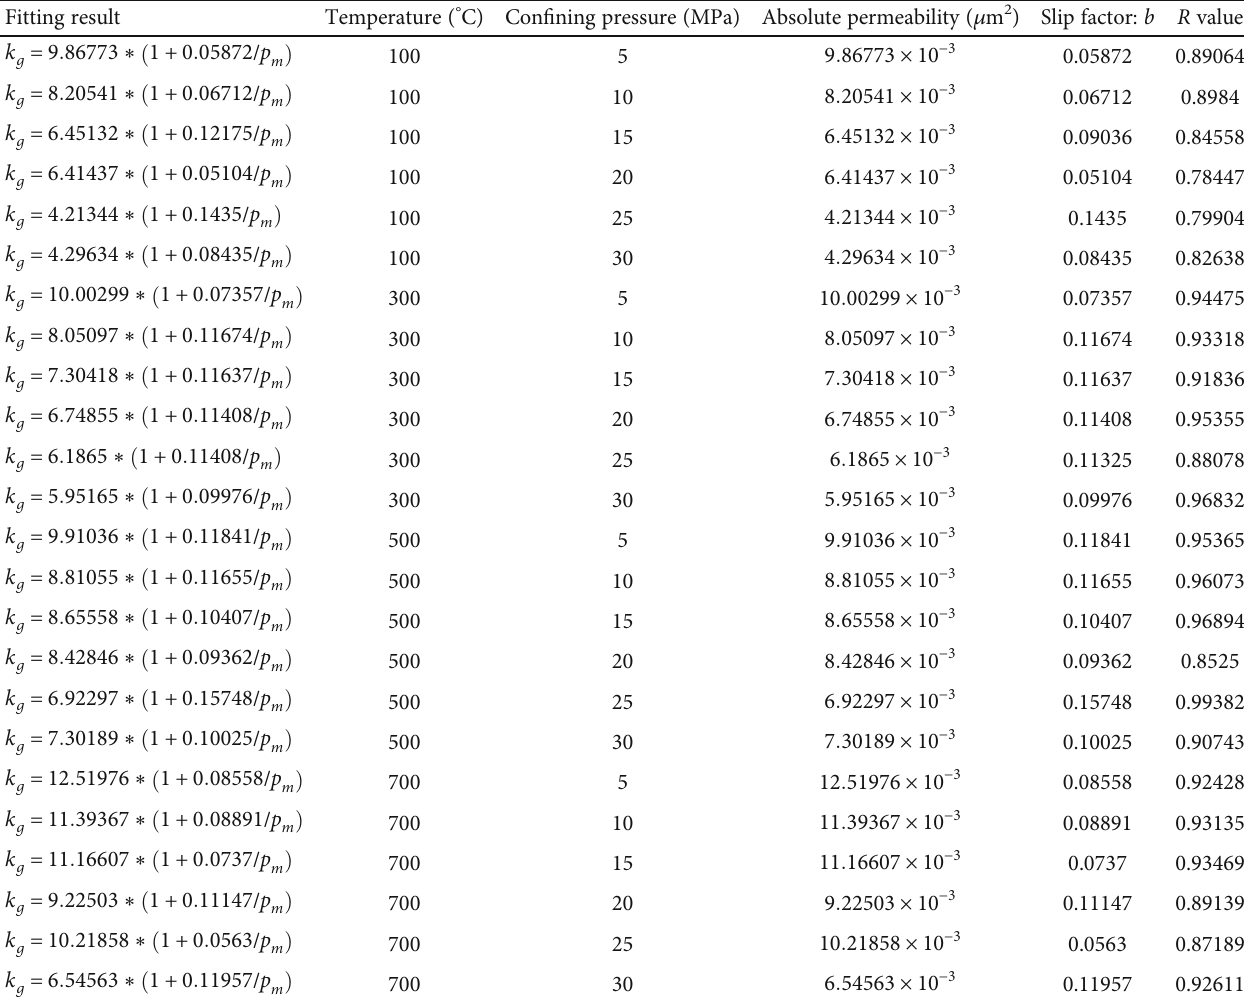
Table 3: Slippage factor fi tting results.